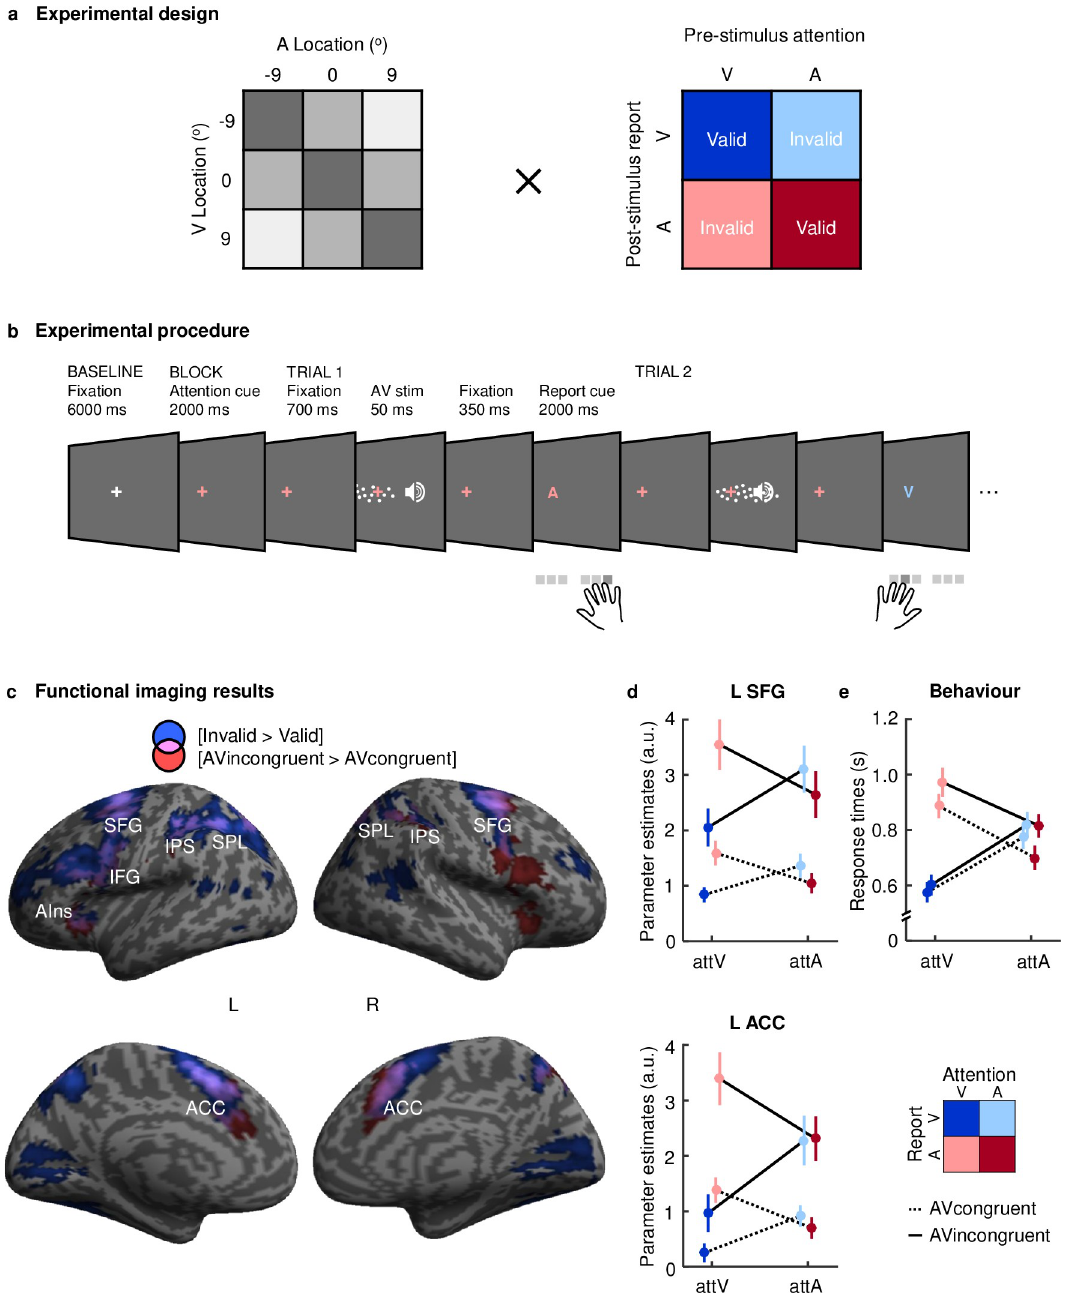
Fig 2. Experimental design and procedure, neuroimaging univariate results, and response times in the fMRI experiment. (a) The experiment conformed to a 3 (auditory location) × 3 (visual location) × 2 (prestimulus attention: attA, attV) × 2 (poststimulus report: repA, repV) factorial design (A for auditory and V for visual). Auditory and visual signals were independently sampled from 3 locations along the azimuth ( − 9˚, 0˚, and 9˚ visual angle), resulting in 9 audiovisual spatial combinations with 3 levels of spatial disparity: none (0˚; dark grey); low (9˚; mid grey); and high (18˚; light grey). The orthogonal pre- and postcue attention cueing paradigm resulted in two valid (attArepA; attVrepV) and two invalid (attVrepA; attArepV) conditions. (b) Prior to block start, participants were cued to attend to either the auditory or visual signal (via colour of fixation cross); 350 ms after each audiovisual stimulus, they were cued to report their perceived auditory or visual location (via coloured letter: A for auditory and V for visual). Participants responded via a button press using different keypads for each sensory modality. (c) Increased activations for invalid relative to valid trials [Invalid (attVrepA & attArepV) > Valid (attArepA & attVrepV)] in blue, for AV spatially incongruent relative congruent stimuli [AVincongruent (AV disparity 6¼ 0˚) > AVcongruent (AV disparity = 0˚)] in red and their overlap in pink, rendered on an inflated canonical brain ( p < 0.001 uncorrected at peak level for visualisation purposes, extent threshold k > 0